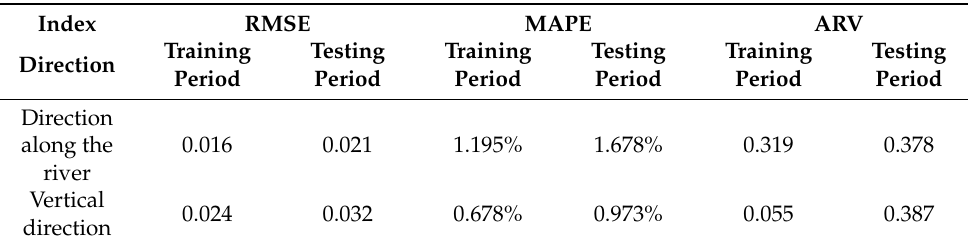
Table 2. Evaluation results of the proposed